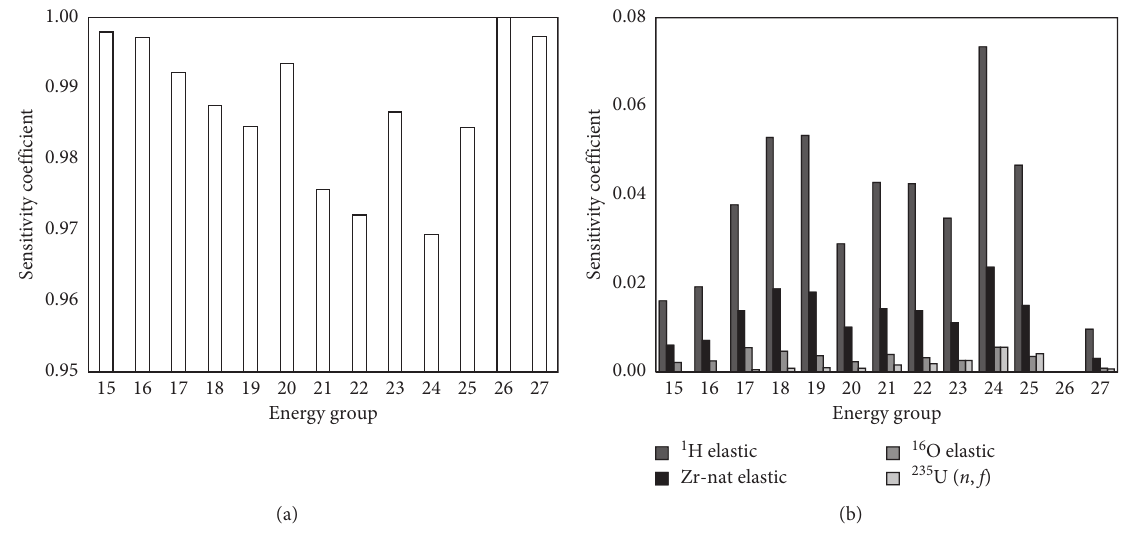
Figure 8: The top five most sensitive sources to the 238 U effective resonance scattering XS and the corresponding implicit sensitivity coefficients. (a) Sensitivity coefficient to 238 U elastic scattering. (b) Sensitivity coefficients to other four